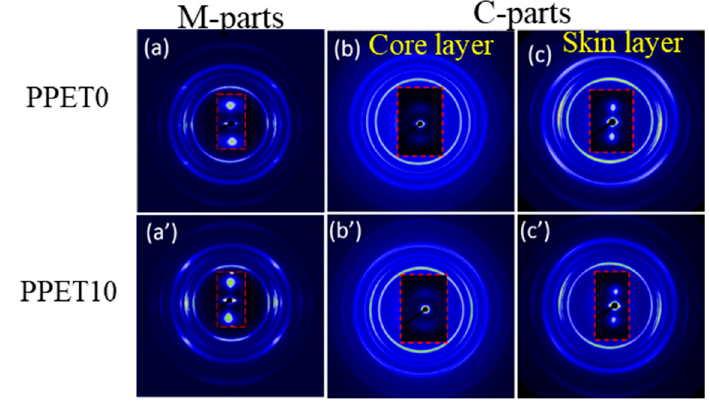
Figure 10. The 2D-WAXD reflection patterns samples at T mold = 80 °C. The flow direction is the vertical direction.